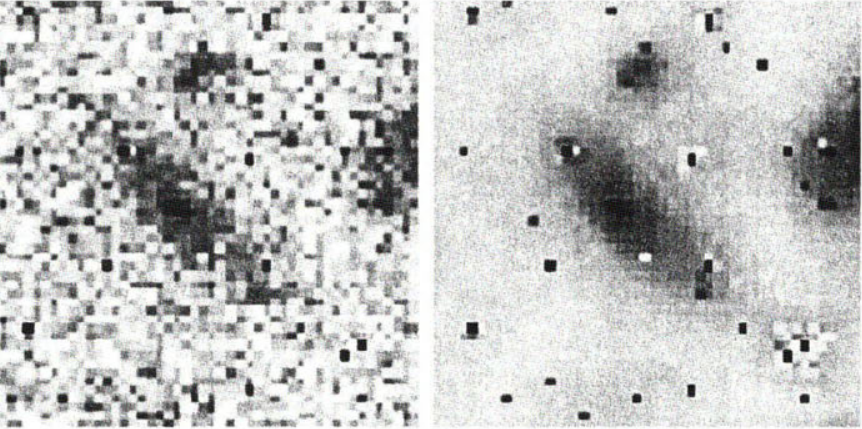
Fig. 2. A combined image of 064-4412 (left panel) and the image after adaptive filtering (right panel). Intensity cutoffs of the images in WFPC2 intensity counts are 0 (lower) and 20 (upper).